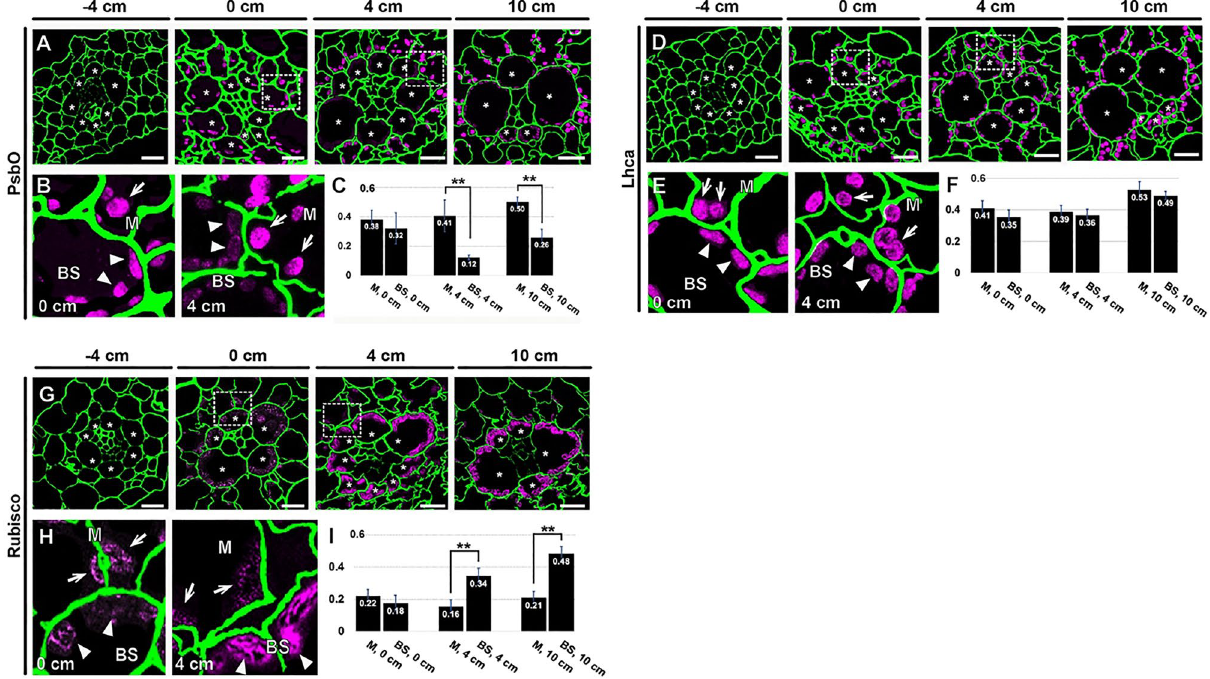
Figure 3. Immunofluorescence localization of chloroplast proteins in M and BS cells at the four leaf development stages. Localization of ( A–C ) PsbO, ( D–F ) Lhca, and ( G–I ) Rubisco large subunit was detected. For each protein, low magnification micrographs (upper images) and higher magnification micrographs of the boxed areas in 0 and 4 cm sections (lower left images) are shown. Cell walls (green) were stained to illustrate Kranz anatomy. BS cells are marked with asterisks in the low magnification images. M and BS chloroplasts are indicated with arrows and arrowheads, respectively, in high magnification images. M chloroplasts are more strongly stained by the PsbO in 4-cm section ( B ). The opposite is true Rubisco in 4-cm sections (H) . Scale bars: 10 µm. Inset graphs ( C,F,I ) plot fluorescence intensities from M and BS chloroplasts in 0- 4-, and 10-cm sections. Chloroplast fluorescence values were normalized with cell wall fluorescence intensity in each micrograph. Error bars depict standard SDs ( ** , p < 0.01; Student